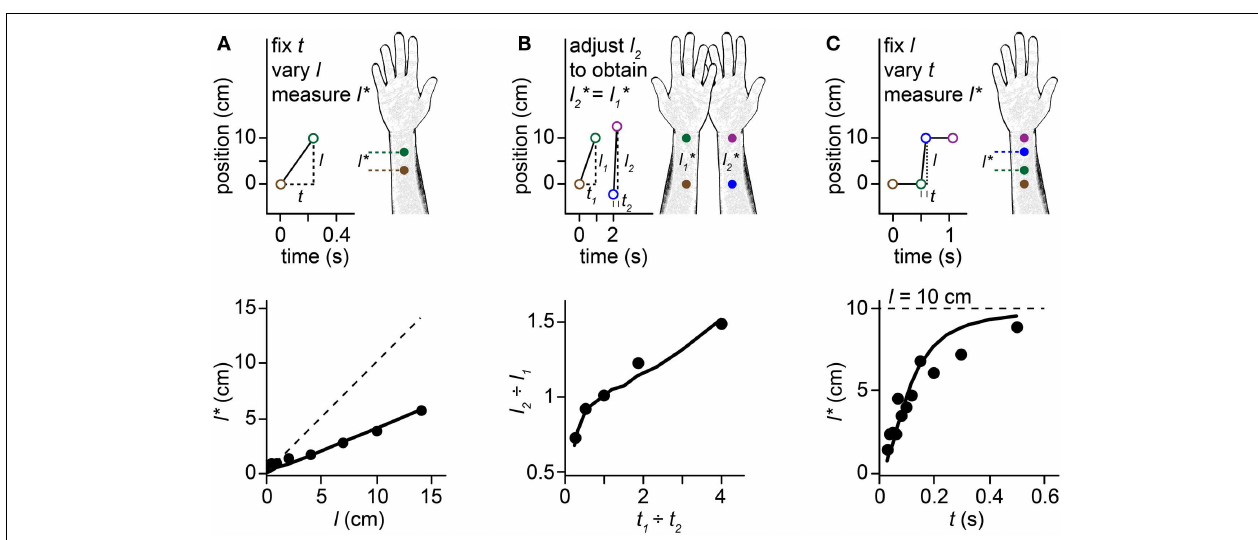
same spacing as a more closely spaced pair of taps ( l 1 < l 2 ) delivered to the left forearm at longer ISI ( t 1 > t 2 ). Bottom : the spacing ratio, l 2 -to- l 1 , resulting in perceived equality of spacing on the two arms, as a function of the ISI ratio, t 1 -to- t 2 . Filled circles: human perceptual data from Lechelt and Borchert (1977). Curve: fit of the Bayesian model. Data points from left to right had t 1 = 0.2, 0.35, 0.5, 0.65, and 0.8s, with t 2 = 1.0s − t 1 , and l 1 = 10cm. (C) Top : 4 taps delivered to two skin sites are perceived as hopping sequentially along the arm, because the short ISI ( t ) between taps 2 and 3 results in contraction of the perceived distance between them ( l * < l ). Bottom : the perceived length from taps 2–3 asymptotically approaches the actual length ( l = 10cm, dashed line) as ISI is increased. Filled circles: human perceptual data from Kilgard and Merzenich (1995). Curve: fit of the Bayesian